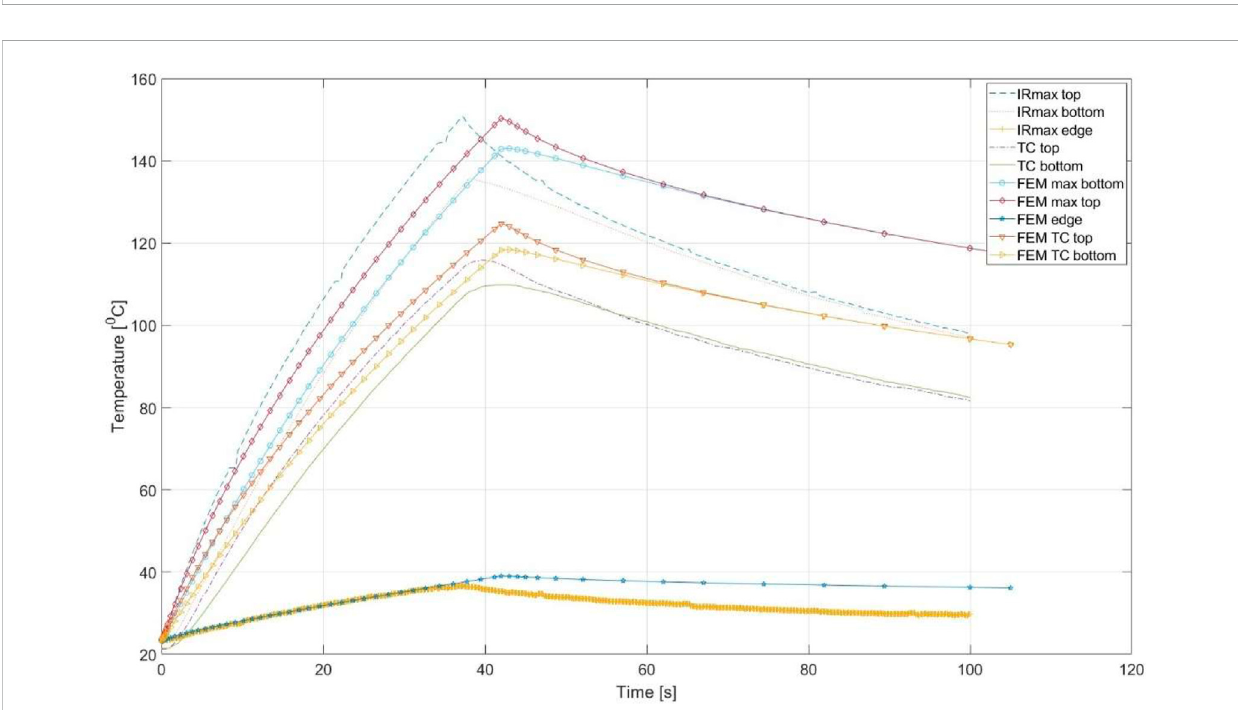
FIGURE 18 Temperature measurements cross-ply [0,90] 9s plate (A1). The surface temperatures were measured via Optris (top surface), FLIR (bottom surface) and two thermocouples placed 100 [mm] from the edge underneath the coil. The FEM values were taken from the simulation model.